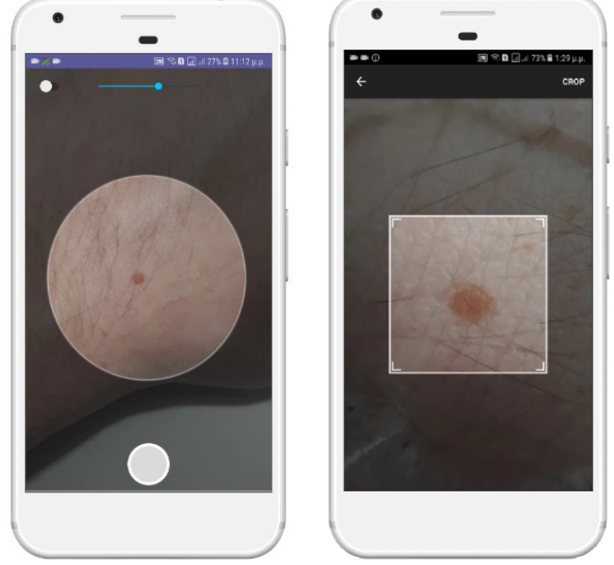
Figure 5. Application screenshots: photo taken on the left and image crop on the right.